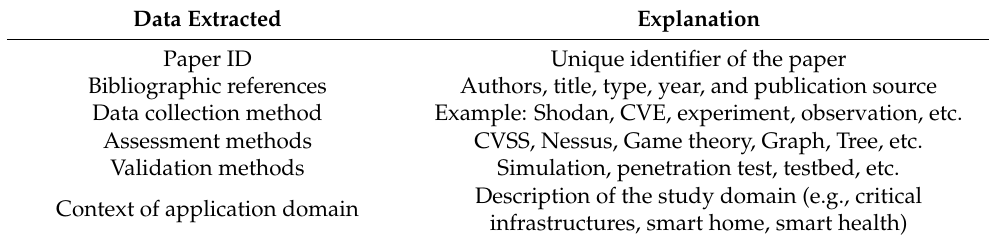
Table 4. Data extraction for each study.